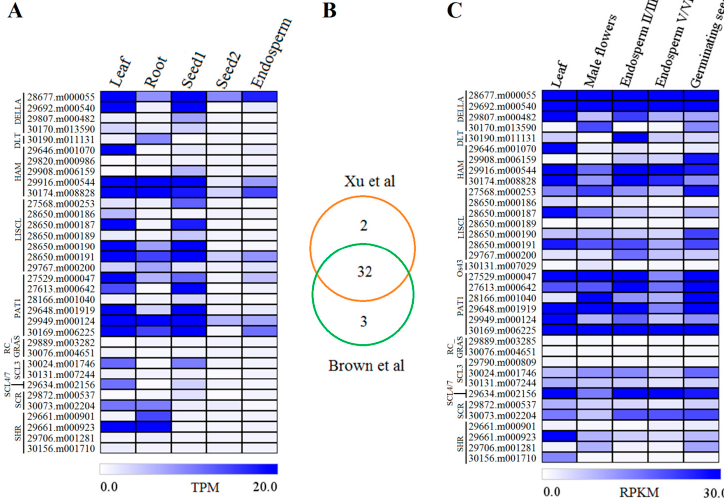
Figure 5. Gene expression profiles of GRAS members in different tissues or organs in castor beans.